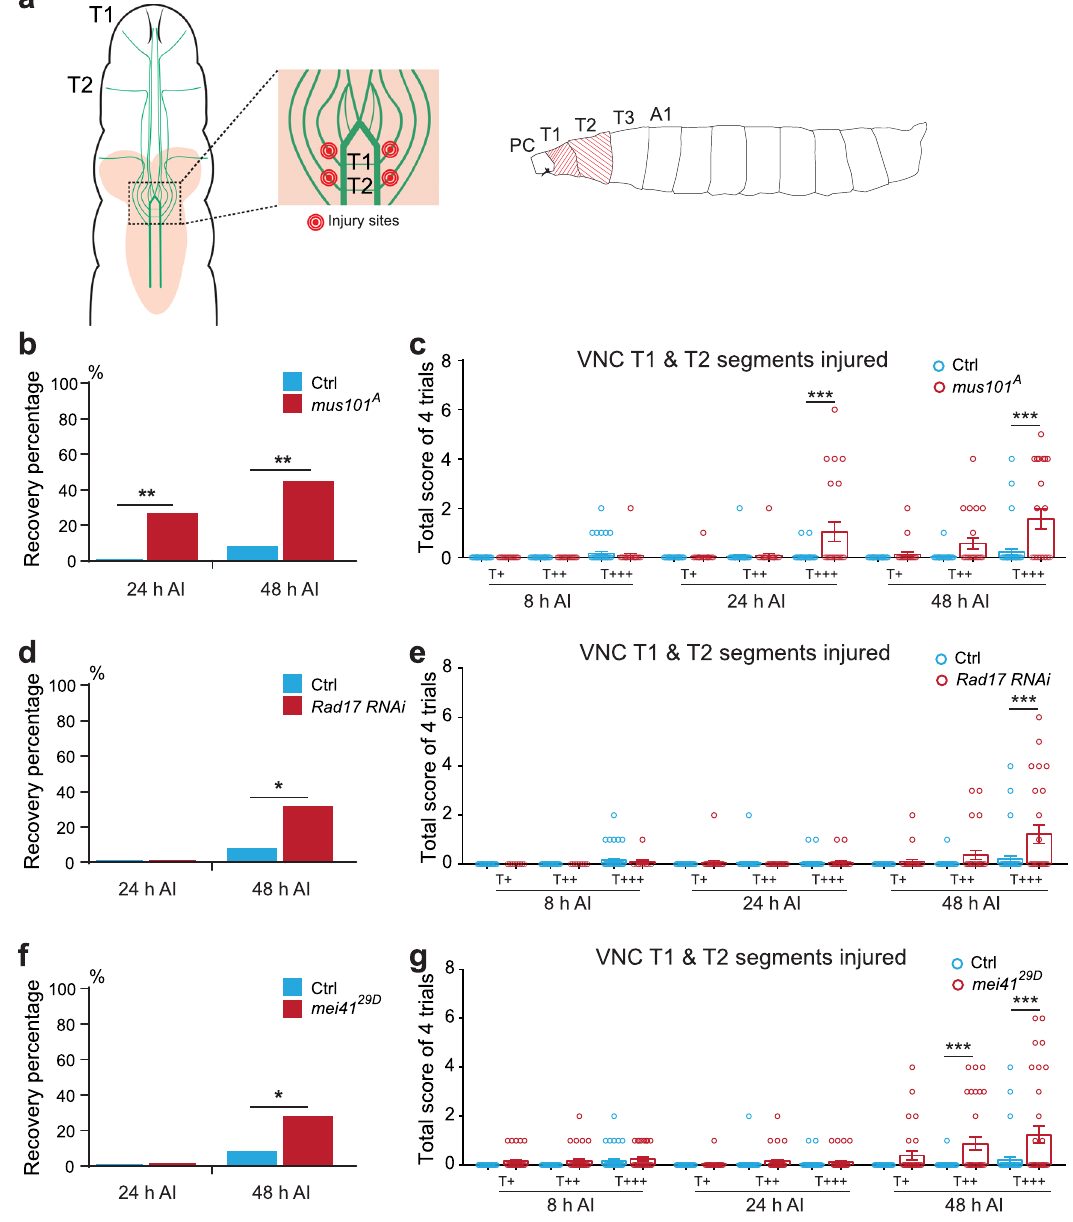
Fig. 4 Inhibiting components of the Atr-associated checkpoint complex promotes behavioral recovery after CNS injury in fl ies. a Class III da neuron axon projection map in the VNC and the VNC injury paradigm. There is a segment-wise somatosensory map for gentle-touch: class III da neuron axons project into the VNC in an anterior-posterior pattern. Axons from the T1 segment constitute the anterior-most T1 bundle within the VNC. The T1 and T2 axon bundles are injured by targeting the nerve bundles right before they enter the commissure region, as marked by the red dots. Gentle-touch response is then performed by stimulating the T1 or T2 segments using an eyelash. A total of four trials are scored for each larva. PC, pseudocephalon; T, thoracic; A, abdominal. b mus101 A mutants show enhanced gentle-touch response after VNC injury, as shown by the Recovery percentage. A larva is de fi ned as showing recovery if the scores from at least two of the four trials are 1 or above. While WTs largely fail to respond even at 48 h AI, signi fi cantly more mus101 A mutants show recovery as early as 24 h AI. P = 0.0013, 0.001. c Gentle-touch response scores at 8, 24, and 48 h AI with various stimulation intensities. Mus101 A mutants display signi fi cantly higher recovery, especially with the T +++ stimulus. d Class III da neuron-speci fi c knockdown of Rad17 mildly increases Recovery percentage at 48 h AI. P = 0.0176. e Class III da neuron-speci fi c knockdown of Rad17 improves response scores at 48 h AI. f mei41 29D mutation mildly increases Recovery percentage at 48 h AI. P = 0.0277. g mei41 29D mutation improves response scores at 48 h AI. N = 41 larvae for Ctrl, 23 for mus101 A , 33 for mei41 29D , 11, 26, and 26 for Rad17 RNAi at 8, 24, and 48 h. Data are presented as mean values + / − SEM. * P < 0.05, ** P < 0.01, *** P < 0.001 by two-sided Fisher ’ s exact test ( b , d , and f ), one-way ANOVA followed by Tukey ’ s test ( c , e , and g ). Source data are provided as a Source data fi